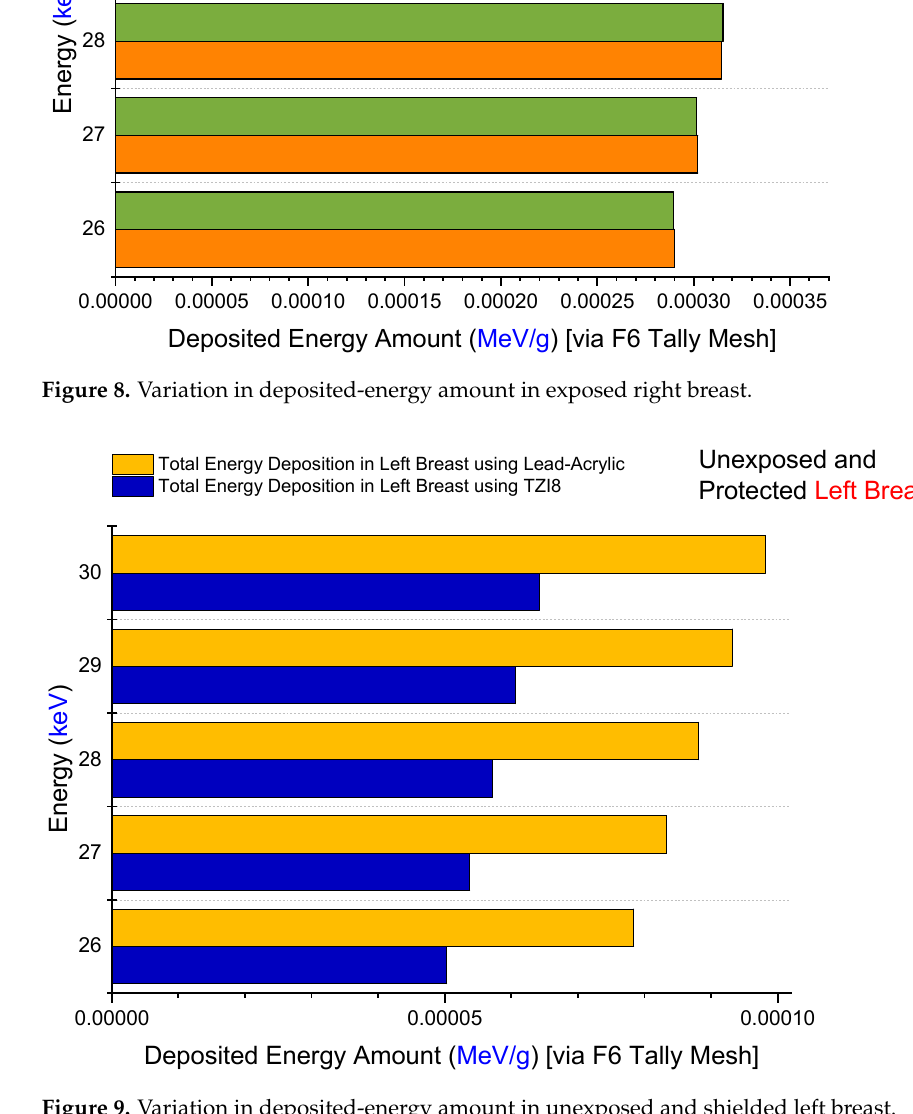
Figure 10. Variation in deposited energy amounts in left breast using TZI8 and lead ‐ acrylic shielding screens. In situations when TZI8 is implemented as a protective screen, the overall skin dose is much lower than when lead acrylic is used. In fact, this is a previously noted observation associated with total breast dose. Since the volume of the whole skin layer is much less than the geometry of the modelled breast, the values in Figure 10 are significantly less than the energy deposited in the breast. This condition may alternatively be seen as the outcome of a discrepancy in volumes. In addition, for TZI8 and lead acrylic, the amount